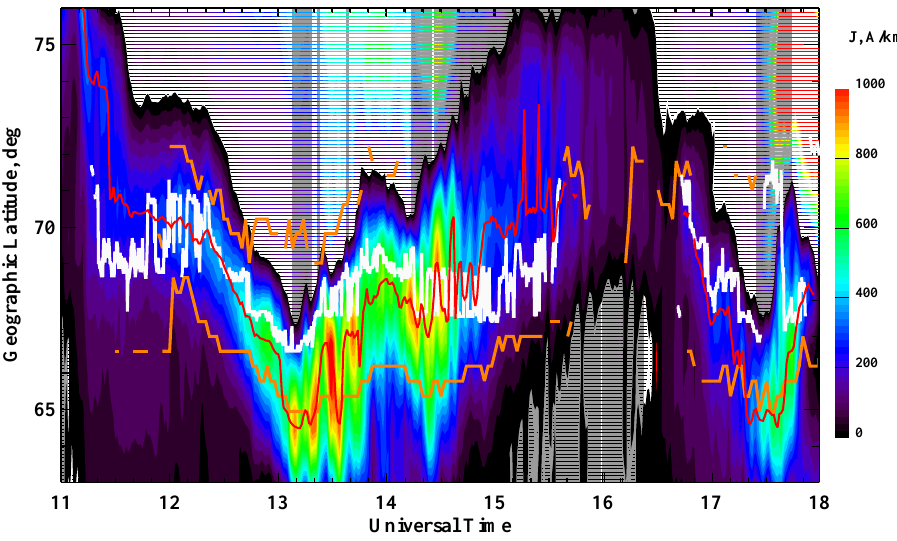
Fig. 4. The contour plot of the equivalent current density J (east-west component) at 24.8 ◦ E (geographic) as a function of UT and geographic latitude. The scale for the current density in A/km is shown on the right. The contours filled with the solid color (horizontal lines) correspond to the eastward (westward) electrojet. The intervals of northward (southward) IMF are marked by the dark grey (white) background. The location of the center of eastjet (maximum of J along the meridian) is shown by the red line. Also shown are the latitudinal positions of the power maximum along the STARE beam 8 (white line) and CUTLASS beam 9 (orange lines) from Fig. 3.